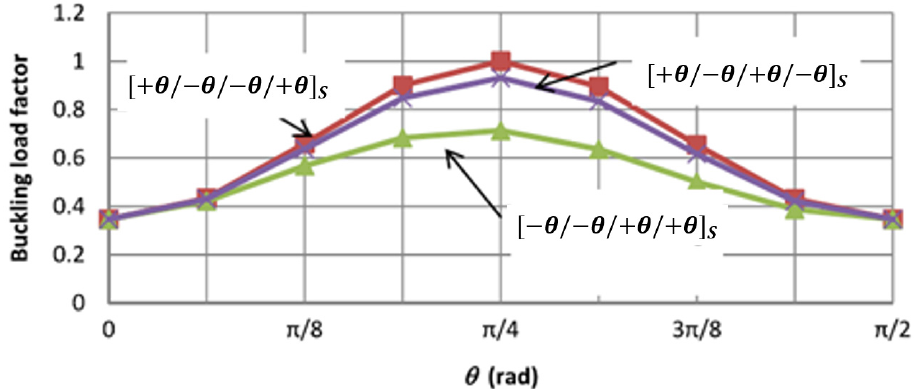
Figure 19. Effect of fibre angle on the buckling load of simply supported laminated plate with symmetric stacking sequences [209].